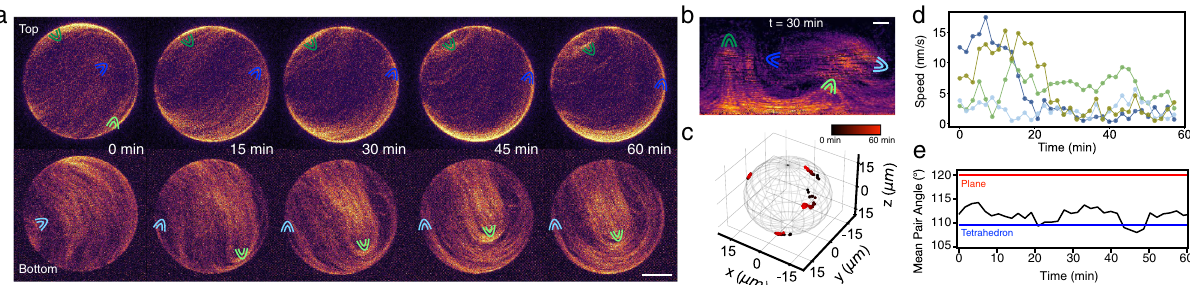
Fig. 5 Jammed state on active actin vesicles. a Time series of the hemisphere projections of a globally jammed vesicle where the four + 1/2 defects are indicated with parabolic symbols. Both the top and bottom hemispheres are shown separately. b The equirectangular projection of the vesicle in ( a ) at t = 30 min where the four + 1/2 defects are indicated with parabolic symbols. Scale bars indicate 10 μ m. c Trajectories of the four + 1/2 defects on a globally jammed vesicle. Time is color-coded; the total time is 60 min. The positions of the defects are extracted from confocal images and projected back on the GUV's surface d Instantaneous speed of the four + 1/2 defects from ( c ). e The time evolution of average angular distances of all six defect pairs 〈 θ ij 〉 where red line indicates the planar con fi guration 〈 θ ij 〉 = 120° and blue line indicates the tetrahedral con fi guration 〈 θ ij 〉 =